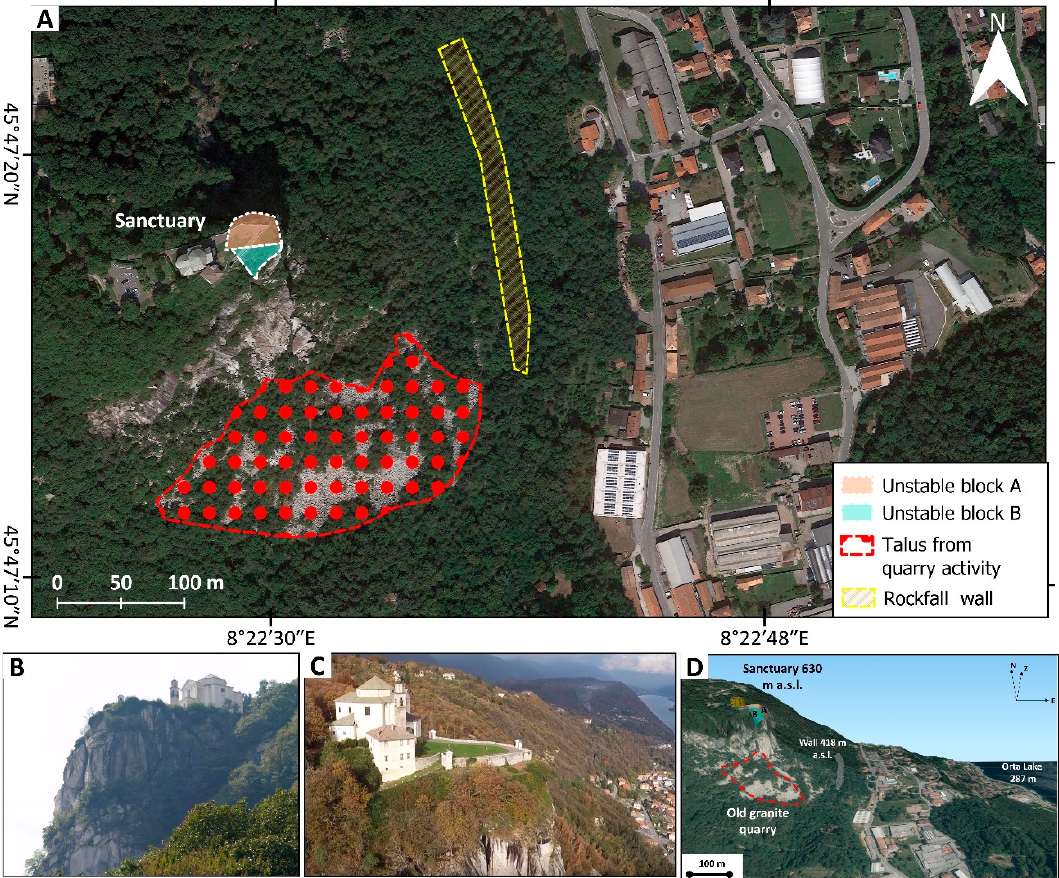
Figure 2. ( A ) shows an aerial image of the Sanctuary site in which are visible: (i) the location Sanctuary and the courtyard (ii) the ancient quarry deposits, (iii) a rockfall wall designed to protect the elements at risk; ( B ) and ( C ) report the view of the Sanctuary and of the unstable slope from North and South, respectively. The picture in panel ( D ) shows a 3D view from the South of the unstable cliff.